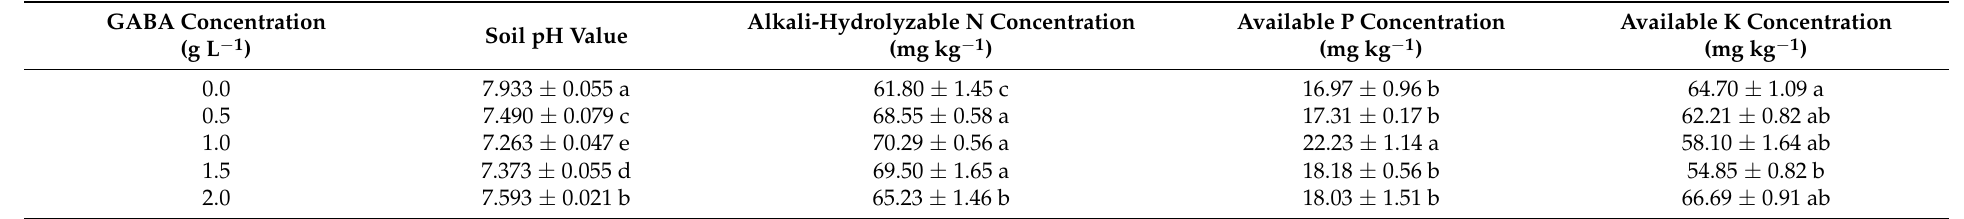
Table 2. Soil pH value and available nutrient concentration under the influence of gamma amino butyric acid.